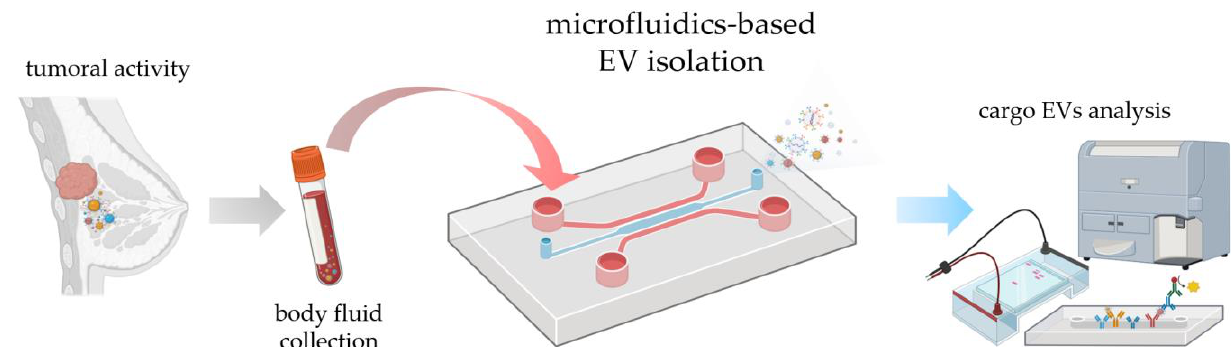
Figure 2. Possible workflow of tumor diagnosis using the microfluidic EV isolation strategy, from sample collection by liquid biopsy to analysis. The elements of the figure are created by BioRen- der.com.